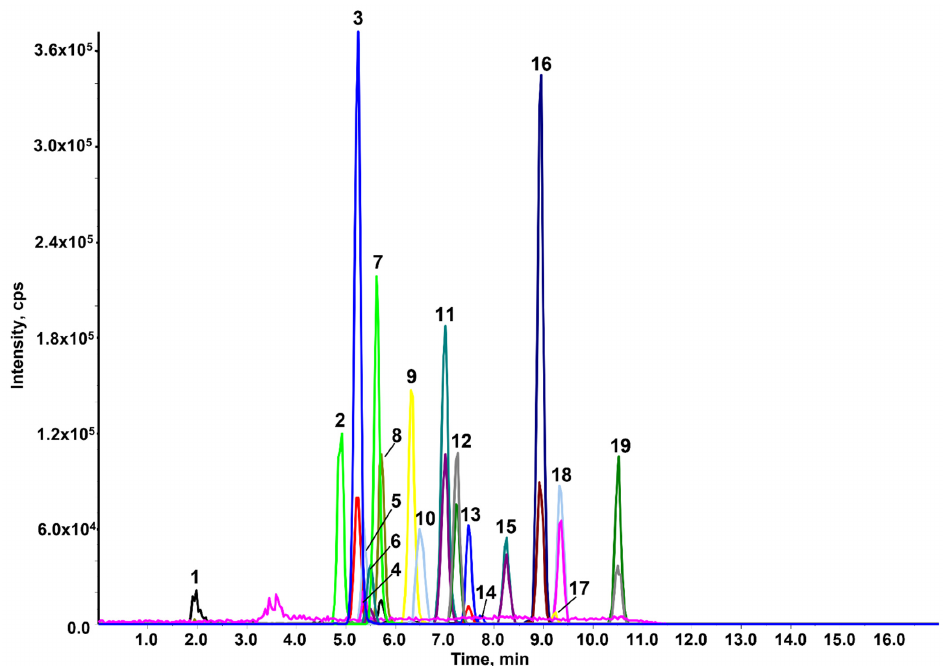
Figure 2. HPLC-MRM of a working standard solution (5 ng injected). Peak legend: 1. DOD, 2. STM, 3. FLD, 4. AZX, 5. MYC, 6. BSC, 7. MXF, 8. TEB, 9. PEN, 10. PRO, 11. BPR, 12. PYR, 13. CLF, 14. CPM, 15. TBF, 16. PPF, 17. CPS, 18. HXT, 19.